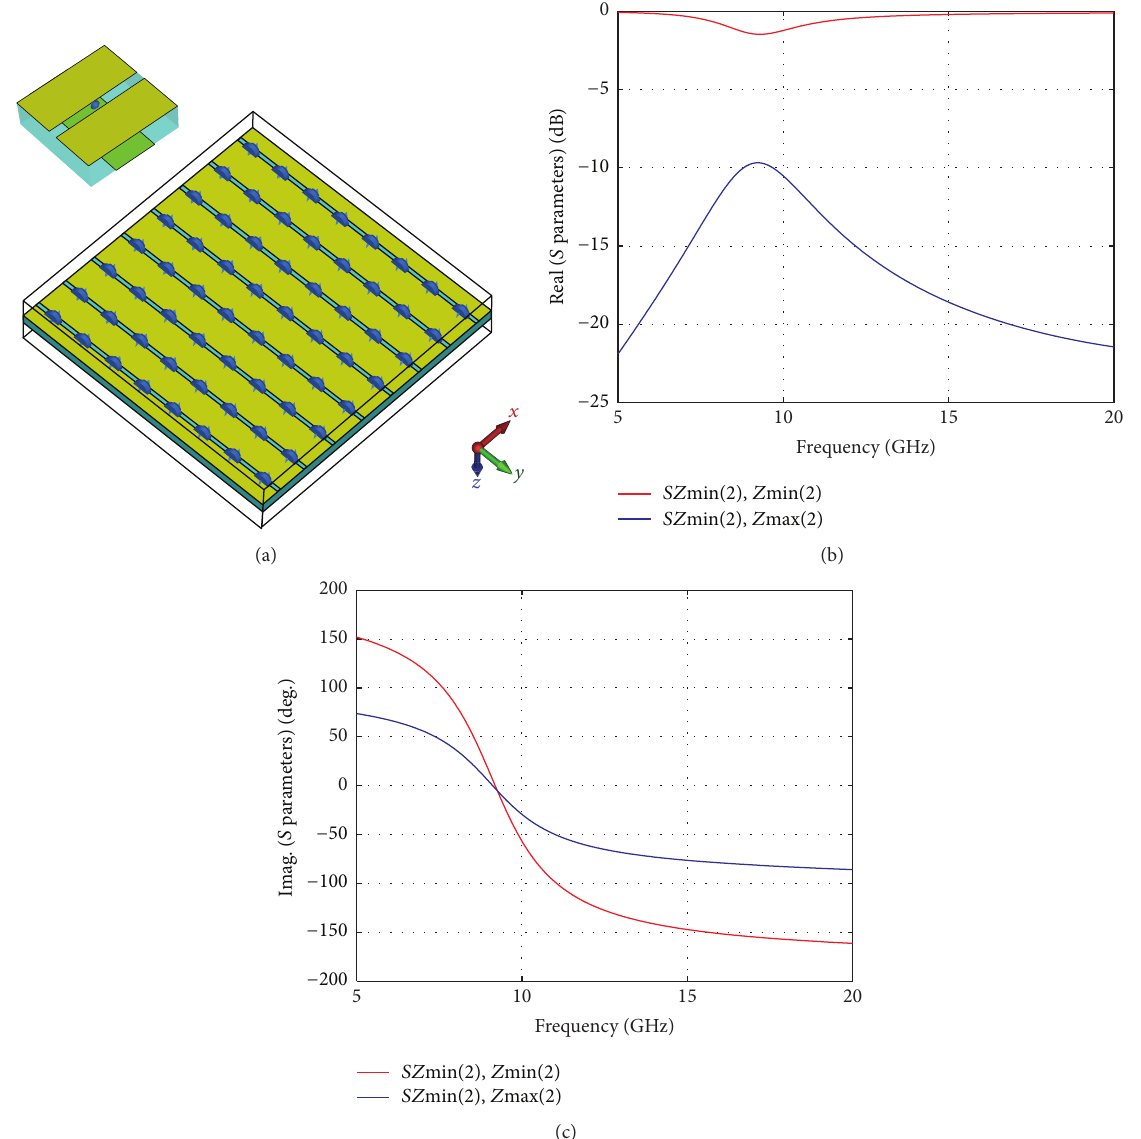
Figure 4: (a) A simulation model of tunable metamaterial superstrate with lumped varactor (in the inset is a unit cell); the transmission (b) amplitude and (c) phase versus